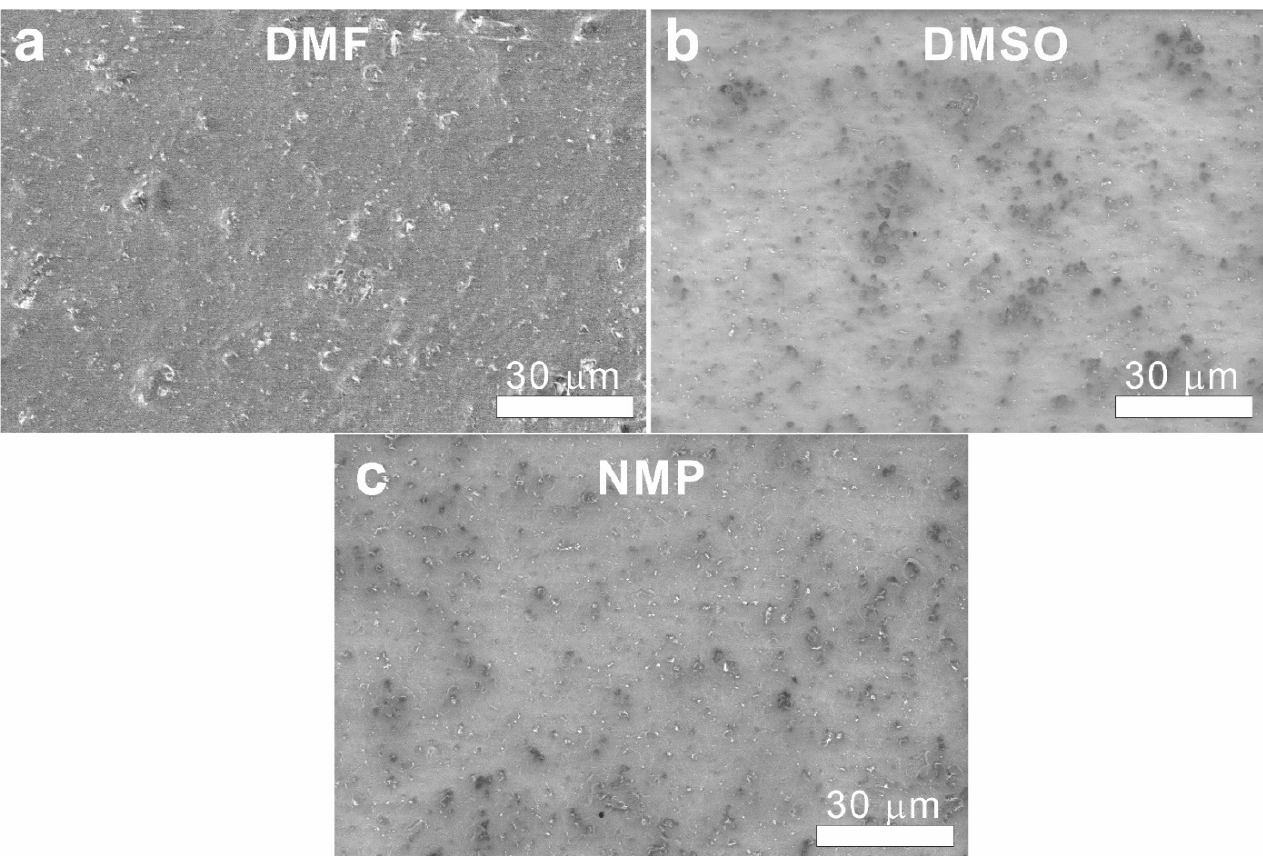
Figure 6. SEM images of the glossy side of a LATP+PVDF membrane fabricated using ( a ) DMF, ( b ) DMSO, and ( c ) NMP solvents.